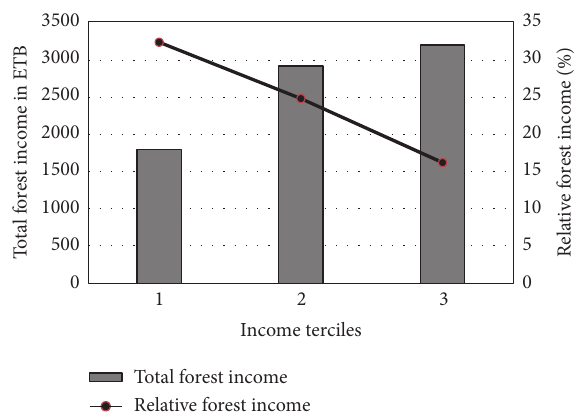
Figure 3: Total and relative forest income (in ETB) across income tercile